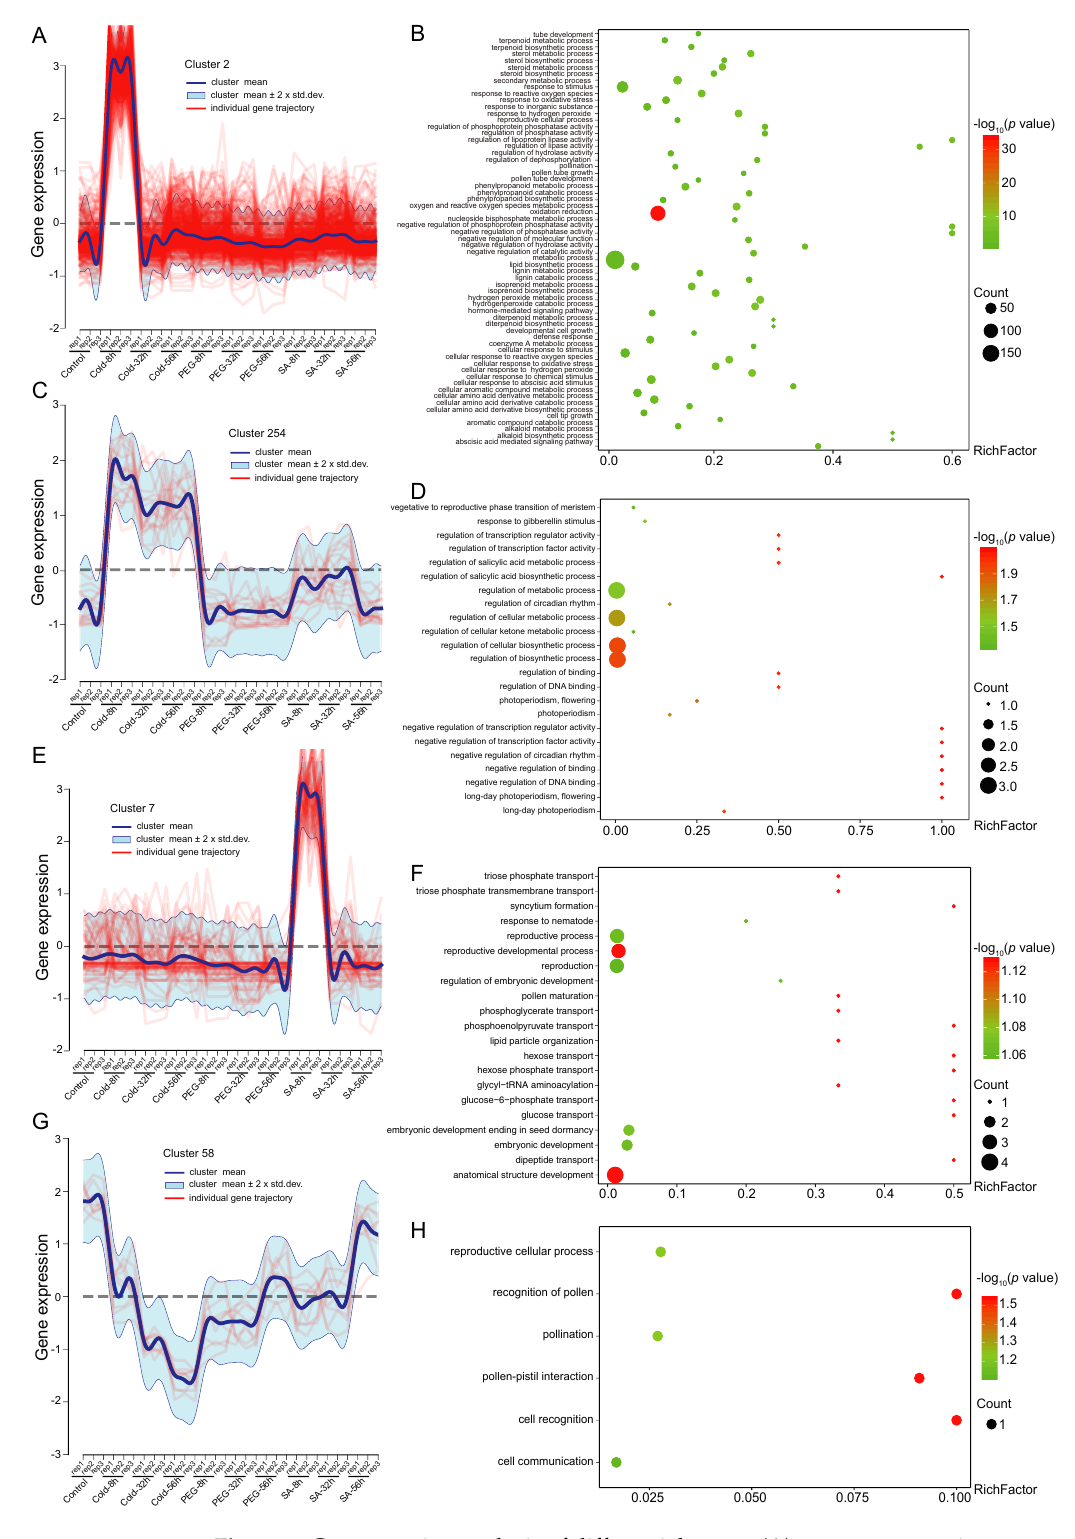
Figure 4. Co-expression analysis of differential genes. ( A ) gene co-expression patterns of cluster 2; ( B ) GO enrichment analysis of genes from cluster 2; ( C ) gene co-expression patterns of cluster 254; ( D ) GO enrichment analysis of genes from cluster 254; ( E ) gene co-expression patterns of cluster 7; ( F ) GO enrichment analysis of genes from cluster 7; ( G ) gene co-expression patterns of cluster 58; ( H ) GO enrichment analysis of genes from cluster 58; ( A , C , E , G ) four clusters of gene co-expression patterns. The y -axis is the value of log 2 measured by normalized gene